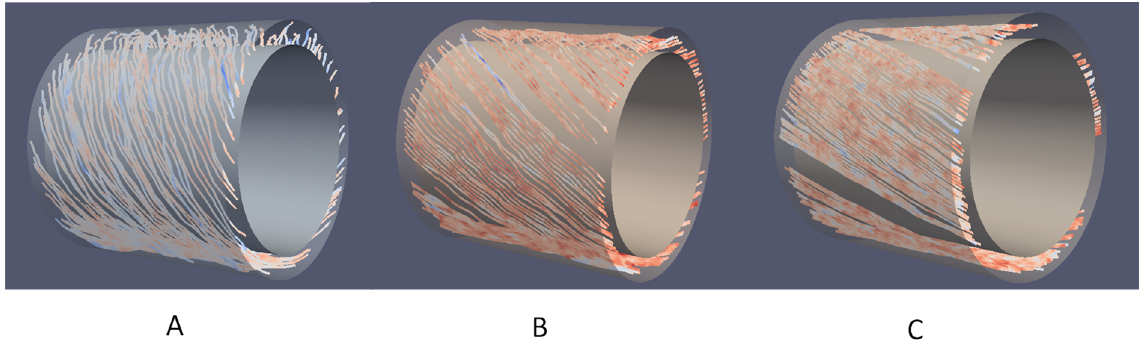
Figure 5. Representation of the streamlines at the centre of the annular geometry for N = 5.12 case ( A ), N = 1.71 case ( B ), and N = 0.85 case ( C ) .